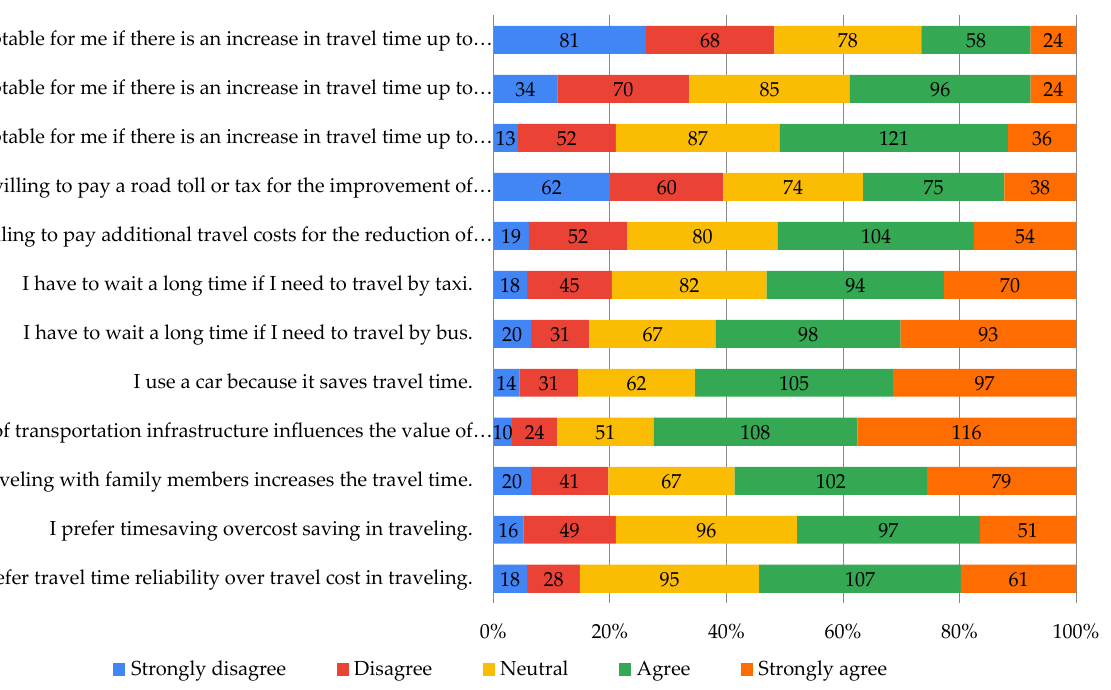
Figure 2. Distribution of response preferences in mode choice behaviors.